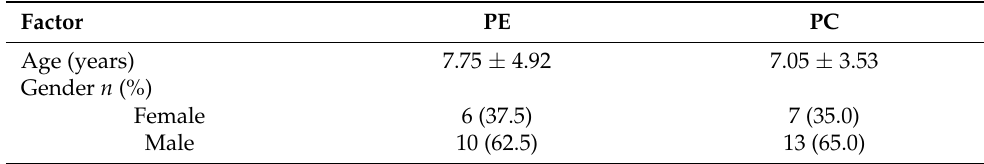
Table 1. The demographic characteristics of